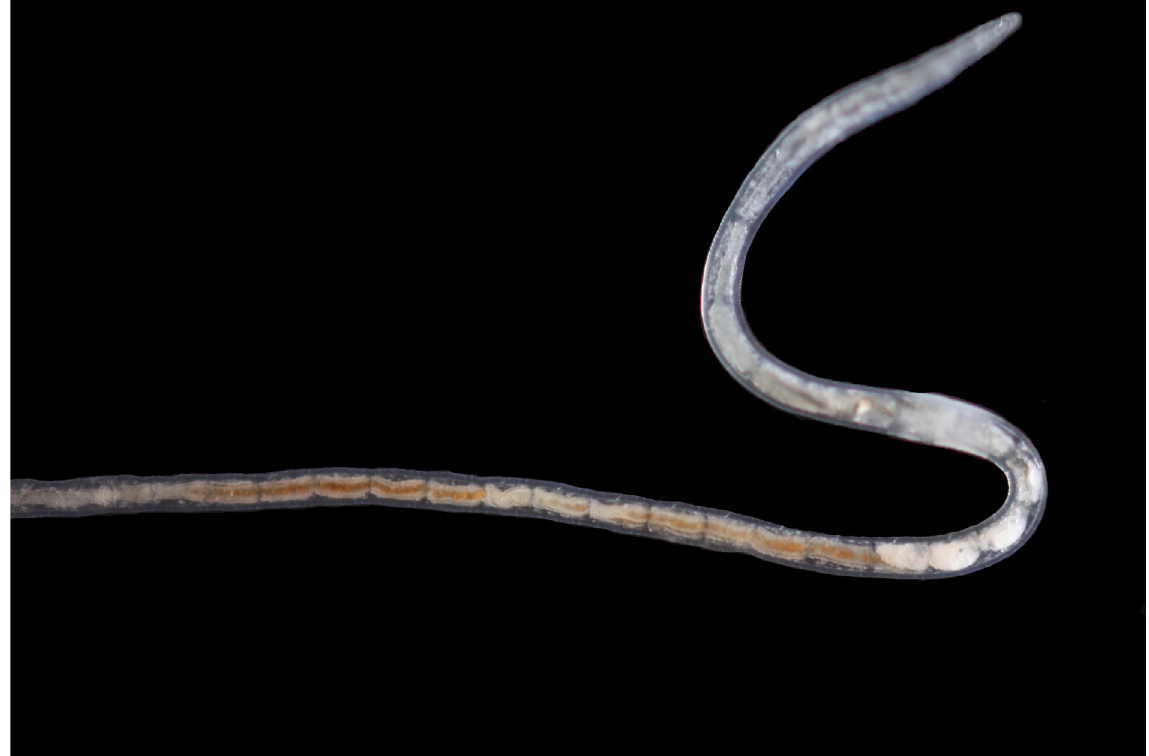
Fig. 1. Specimen of Grania chilensis Prantoni, De Wit & Erséus, 2016. Photograph by Pierre De